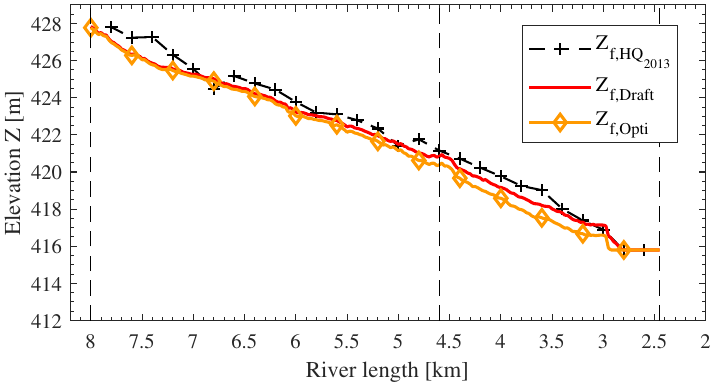
Figure 14. Longitudinal section of the maximum water surface levels: Observed in 2013 (Z f,HQ simulated by the draft scenario (Z f,Draft ) and the simulated optimised case (Z f,Opti